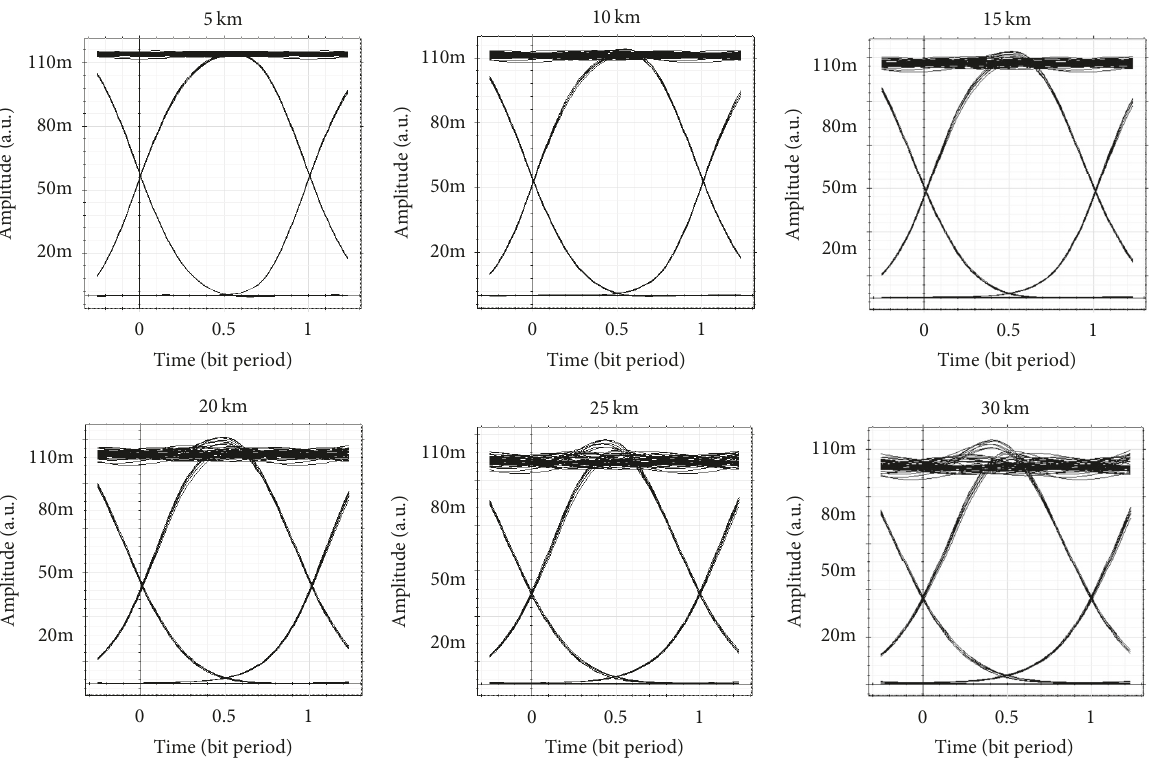
Figure 5: Eye diagrams for different values of OFC